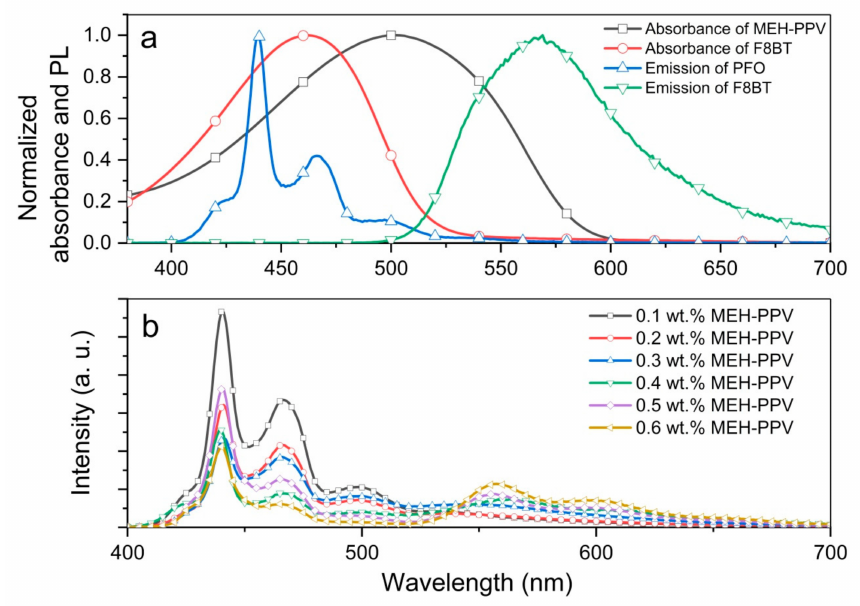
Figure 1. ( a ) The absorption and emission spectra of individual polymers; ( b ) emission spectra of PFO / MEH-PPV-blended thin film with various weight ratios of MEH-PPV.